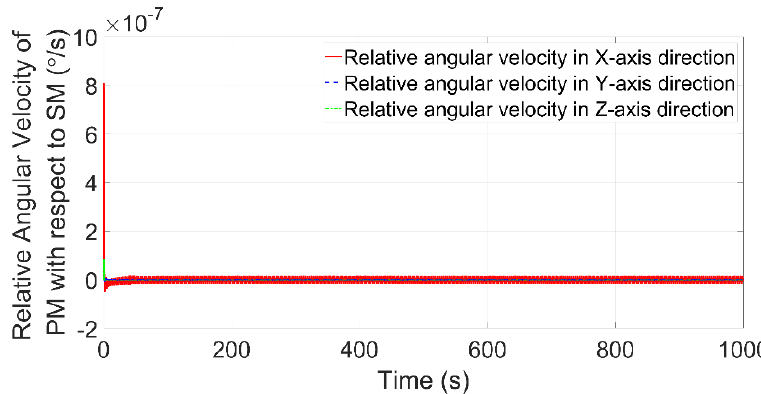
Aerospace 2022 , 9 , 571 Figure 10. Attitude angular velocity of the PM with respect to the SM. Figure 10. Attitude angular velocity of the PM with respect to the SM.